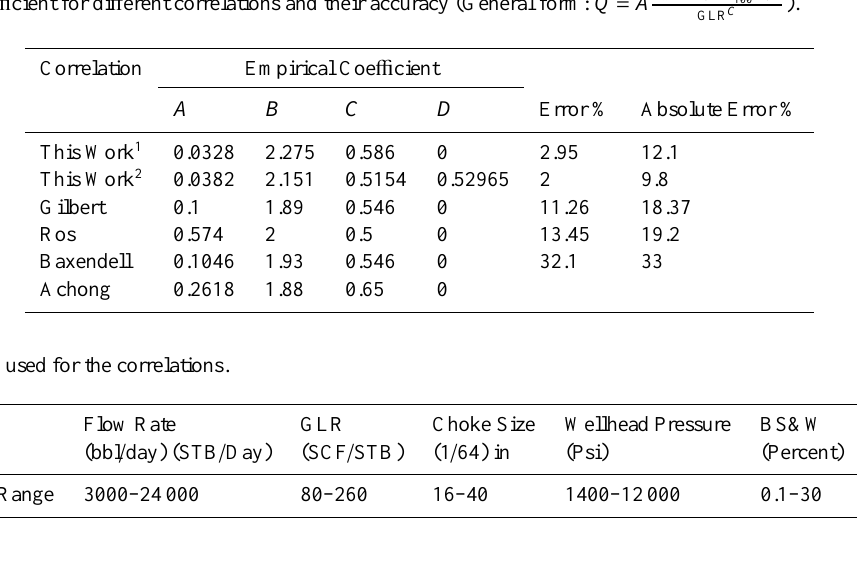
Table 1. Equation coe ffi cient for di ff erent correlations and their accuracy (General form: Q = A P wh S